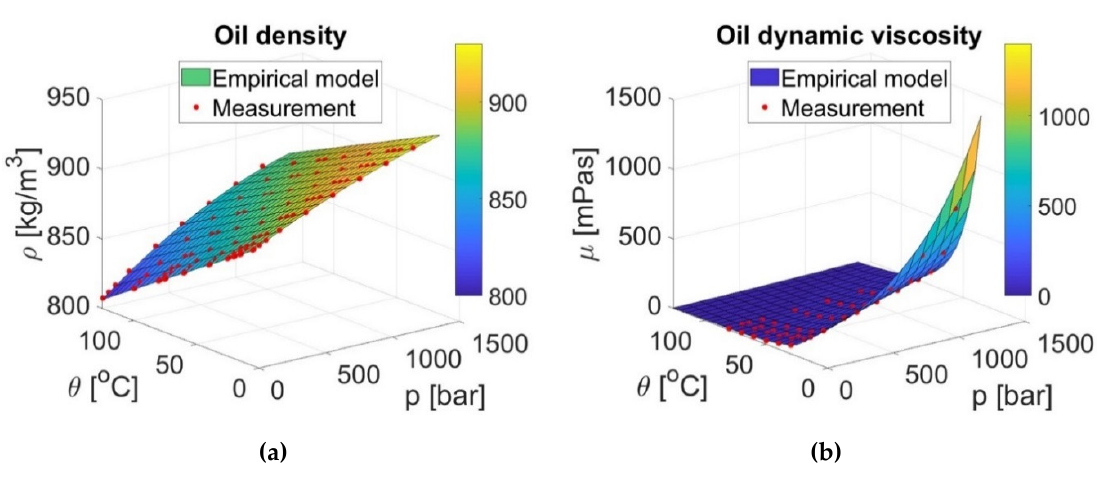
Figure 5. ( a ) Dependence of the density on the pressure and temperature for the oil an ISO 46 viscosity grade; ( b ) dependence of the viscosity on the pressure and temperature for the oil an ISO 46 viscosity grade.